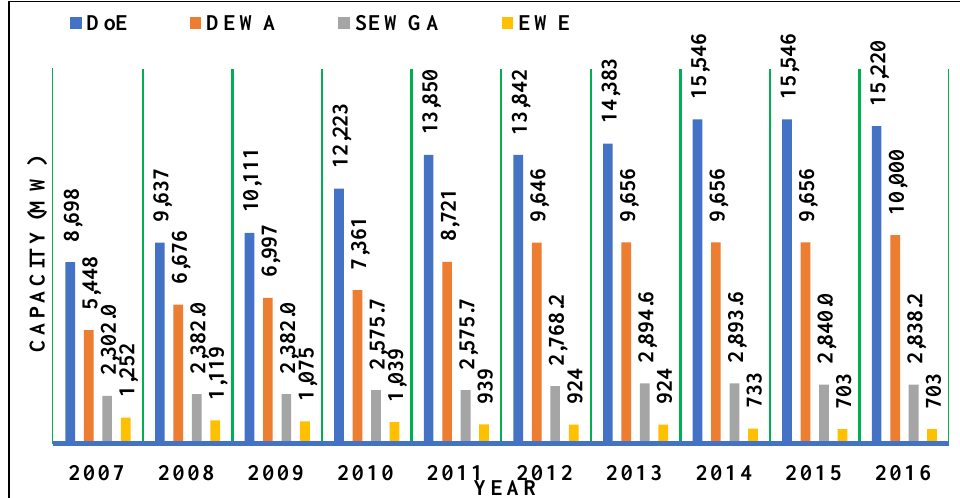
Figure 14. Electricity capacity in DEWA, DoE, SEHA, EWE (MW) [81].